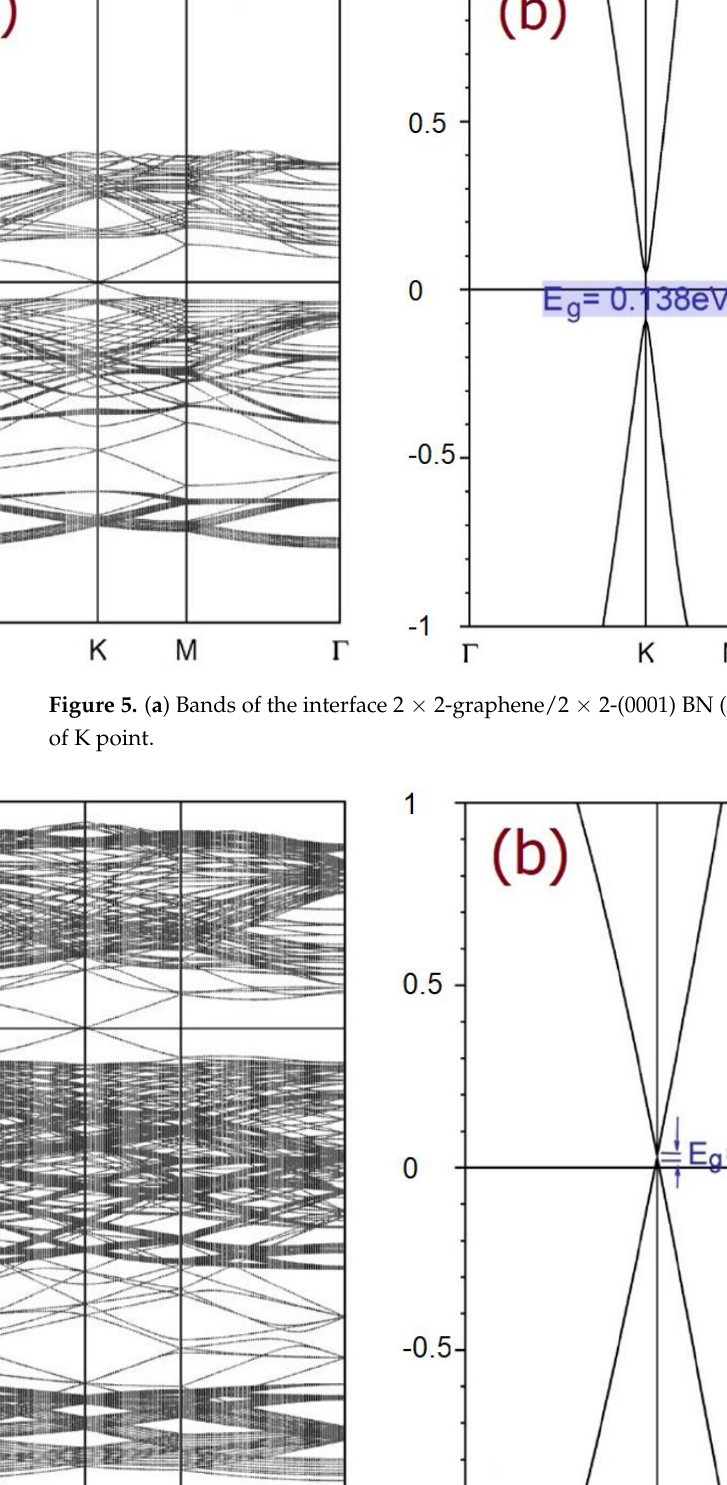
√ √ 3 × 2 3 -(0001) BN and ( b ) zoom